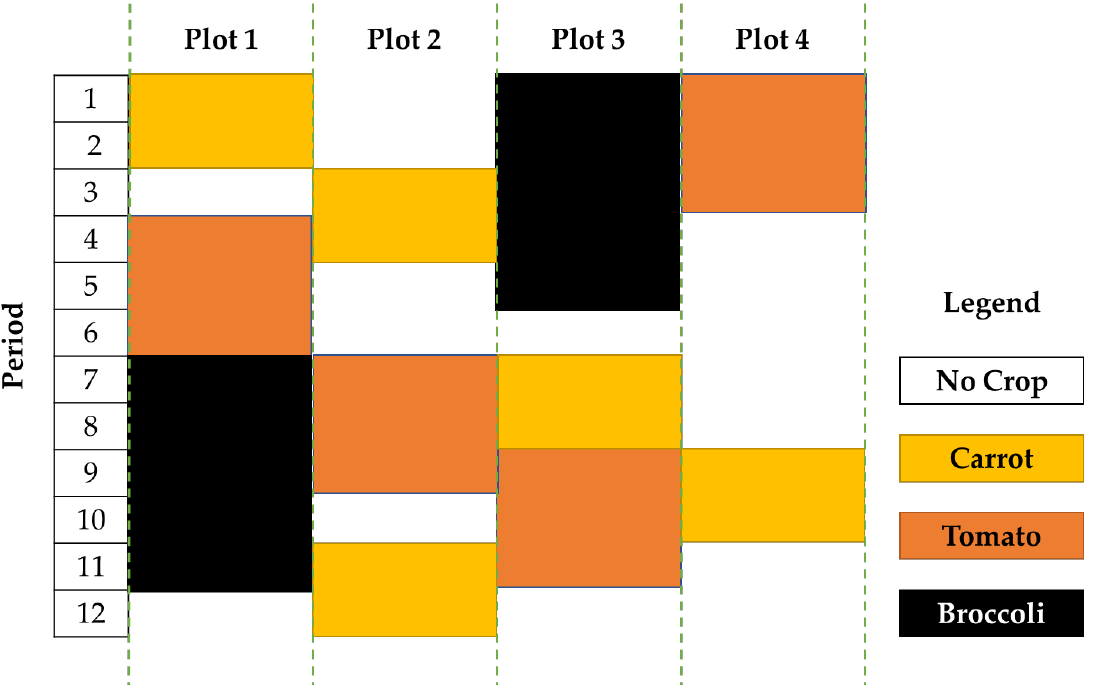
Figure 2. Representation of the solution obtained by Cbc for Case 1. Tomato is cultivated once on each plot. Carrot is cultivated once on plots 1, 3 and 4, and twice on plot 2. Broccoli is cultivated once on plots 1 and 3.